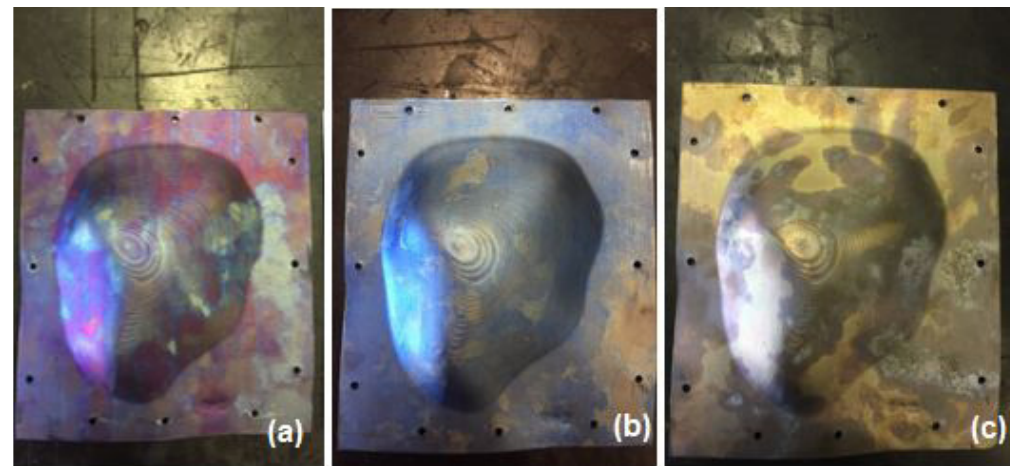
Figure 1. Heat-treated samples: (a) Temperature of 480 ºC. (b) 540 ºC. (c) 595